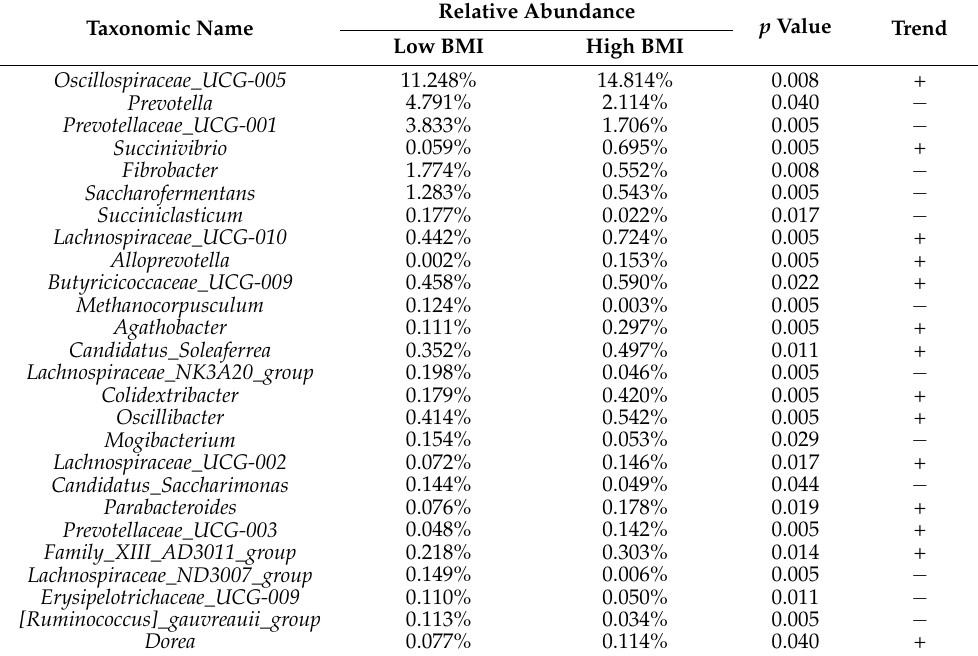
Species with an average relative abundance of less than 0.1% in both groups were excluded. Up-regulated bacteria in Hu sheep with high BMI shown with “+”; otherwise, they are shown with “ −